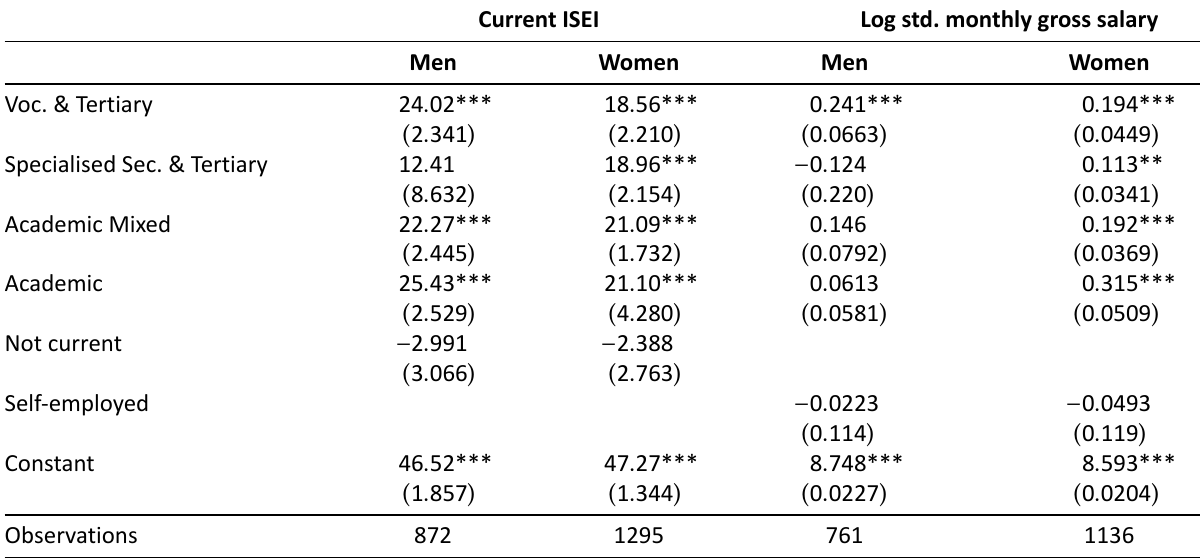
Table 9. Effects of educational clusters on social status and salary by gender (OLS